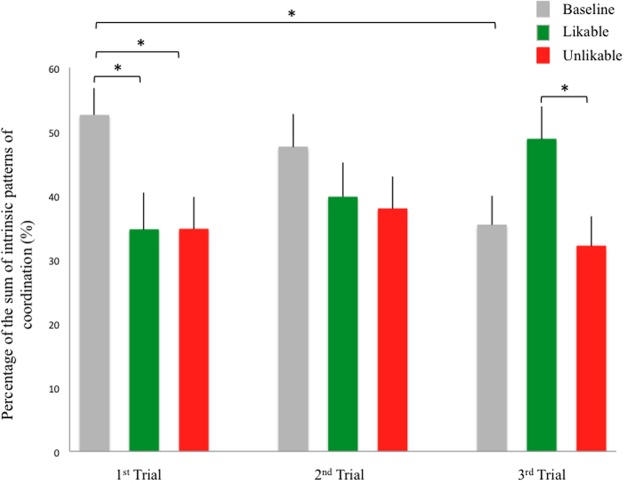
Likability ∗ Trial interaction effect on the percentage of the sum of both intrinsic patterns of coordination in the 100% condition. ∗p < 0.05, ∗∗p < 0.01. Error bars stand for standard errors.